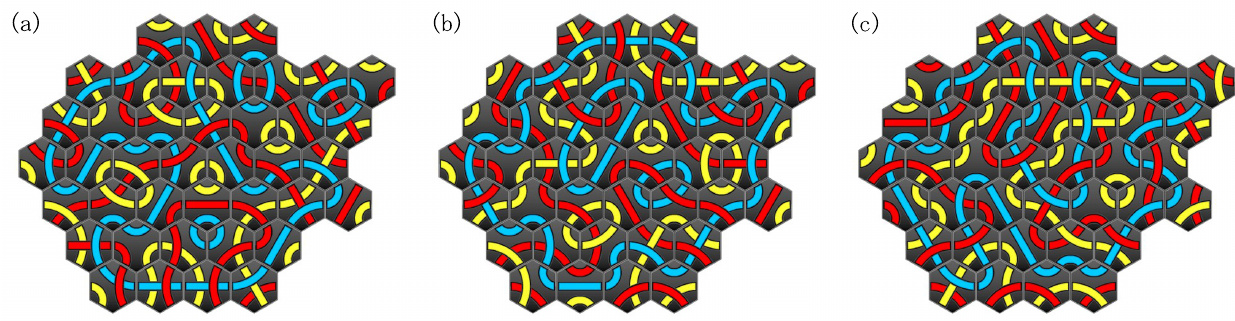
Figure 12. Solutions obtained by solving IP formulations using C1, C2 ′ , C3, C4 and C6 for challenge number 40: after ( a ) 3rd, ( b ) 7th and ( c ) 14th iterations, respectively.